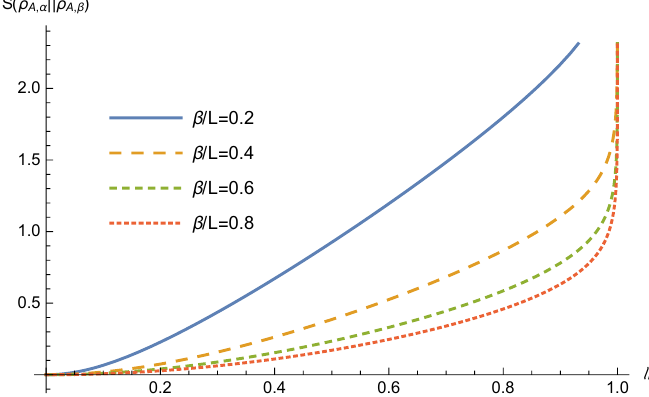
Figure 1 . Relative entropy (2.22) as a function of ‘=L in comparing the reduced density ma- trices for chiral primary state and thermal state of 2D massless scalar. Note that the higher the temperature is, the larger the relative entropy